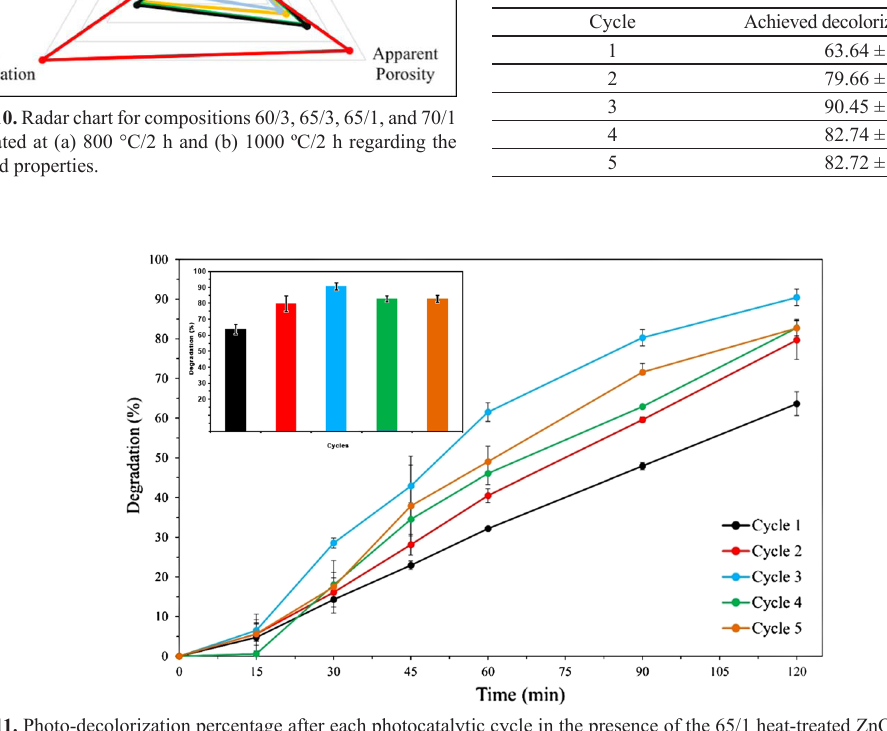
Figure 11. Photo-decolorization percentage after each photocatalytic cycle in the presence of the 65/1 heat-treated ZnO composition at 1000 °C/2 h.